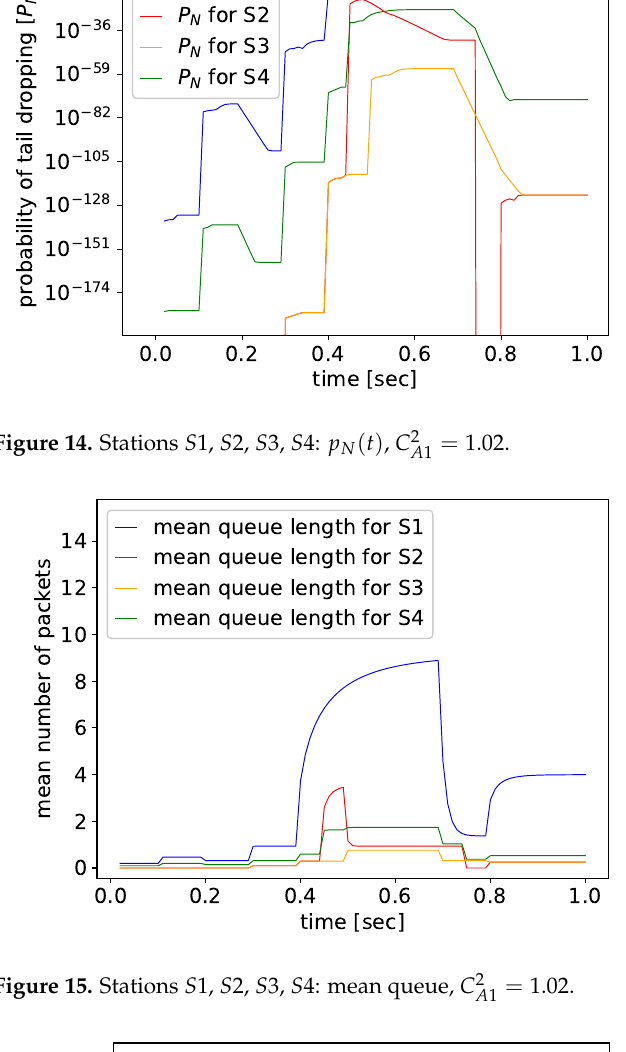
Figure 15. Stations S 1, S 2, S 3, S 4: mean queue, C 2